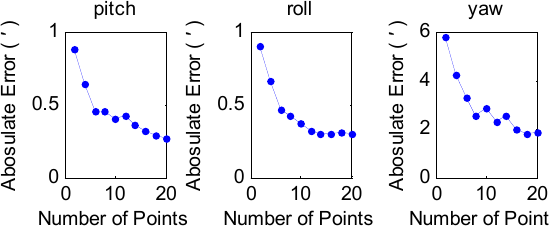
Figure 4. The boresight misalignments vs. the number of control points.